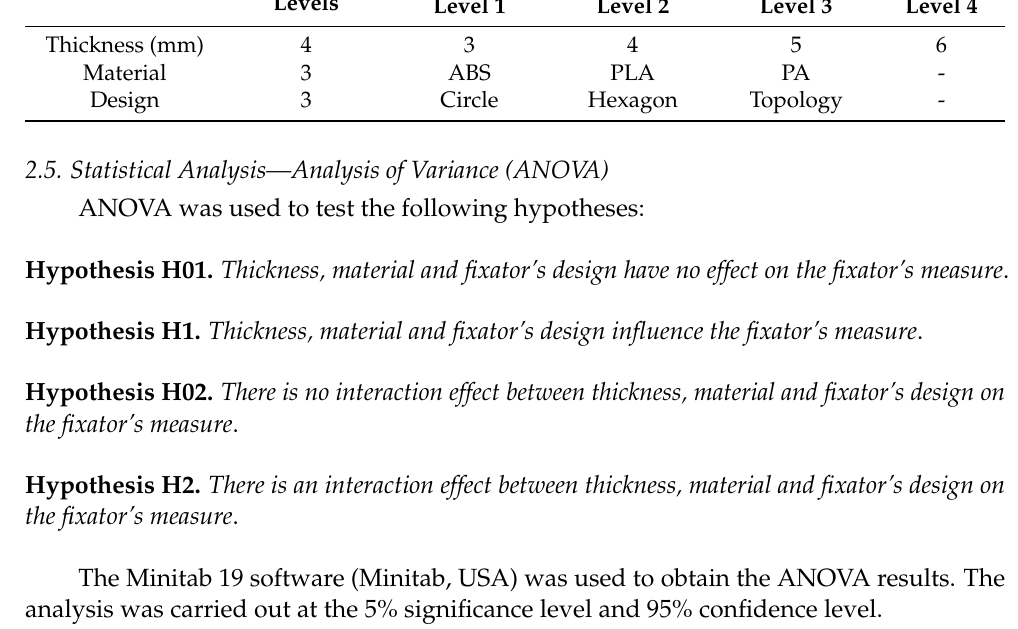
Table 3. Main factors and their corresponding level values. Number of Factor Levels Level